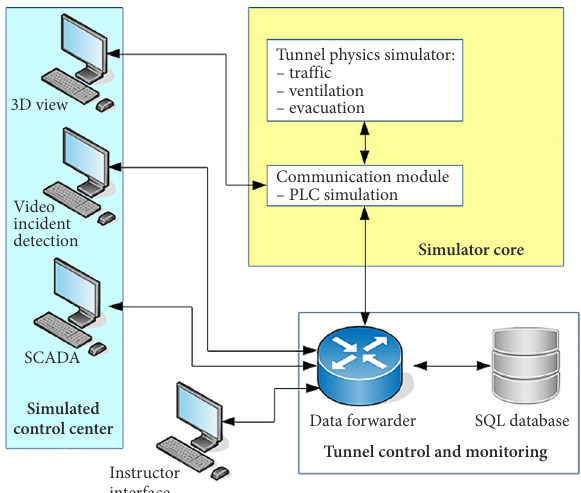
Figure 2. Simulator architecture